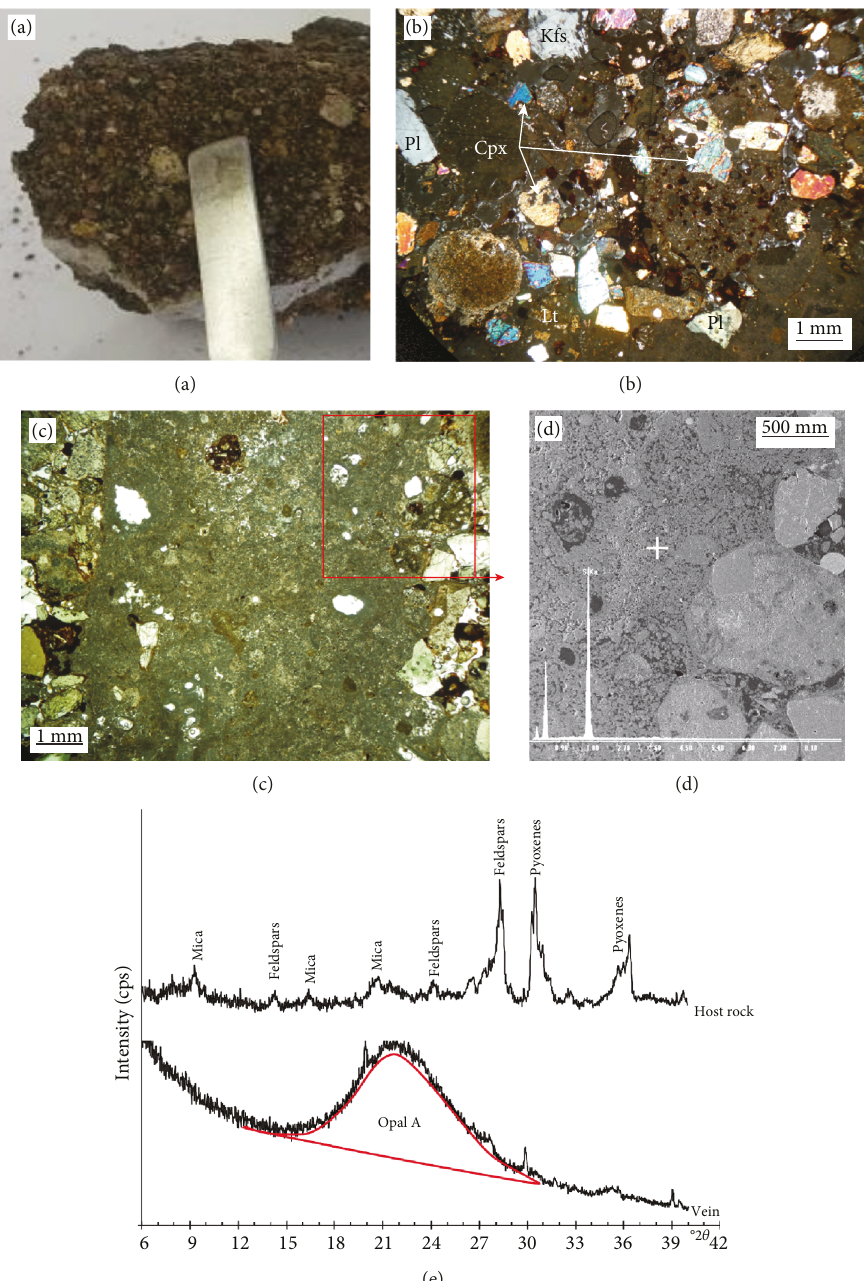
Figure 6: (a) Picture of representative sample (dark host rock and white vein); (b) OM observation of host rock. Kfs: k-feldspar; Cpx: clinopyroxene; Pl: plagioclase; Lt: lithic fragments. (c) OM observation vein; (d) SEM image and EDX spectra of opal; (e) XRD di ff raction pro fi les of the host rock and